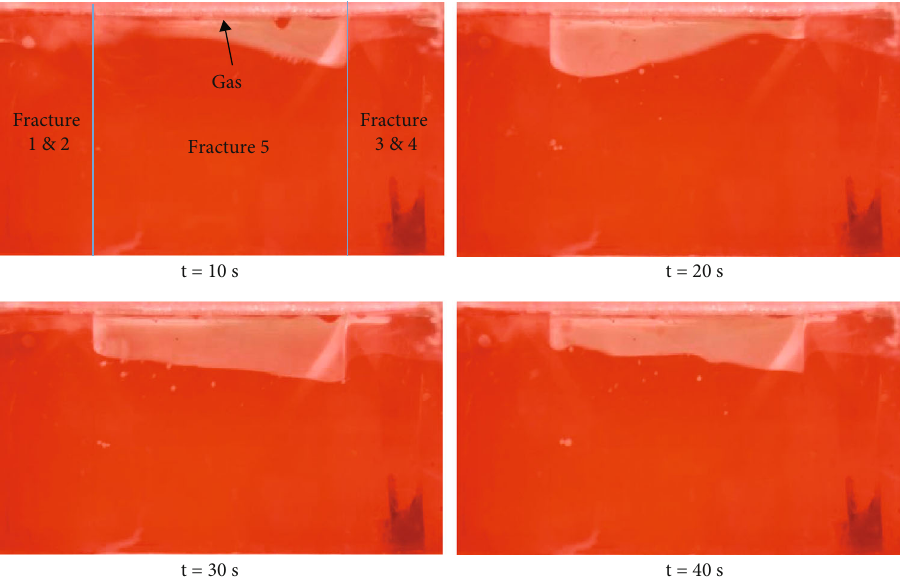
Figure 7: The fl ow structures at W